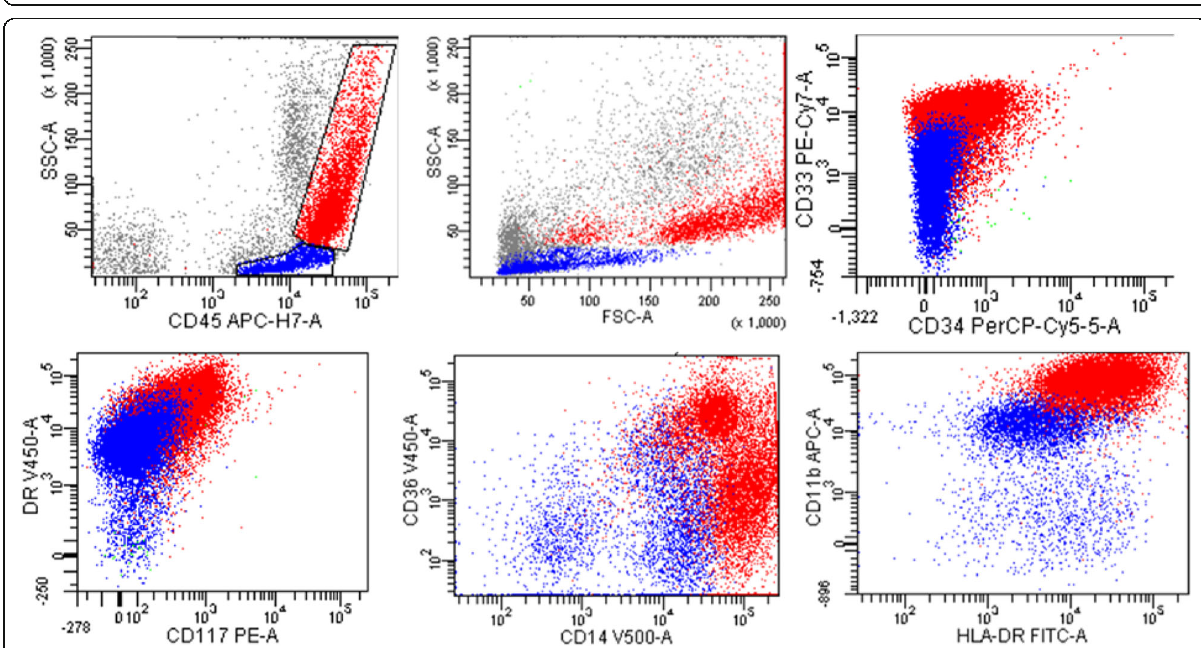
Fig. 4 Flow cytometric analysis of mediastinal lymph node revealed two cell populations with distinct forward and side scatter and CD45 expression intensity. One population with increased side and forward scatter comprised 40% of total events (red). This population expressed CD33, HLA-DR, CD36 (variable), CD14 (bright) and CD11b (bright) and were negative for CD34 and CD117. A second population of cells with decreased forward and side scatter showed a similar immunophenotype with variable expression of CD33 and dimmer CD11b and CD14 (blue). These cells were also negative for CD34 and